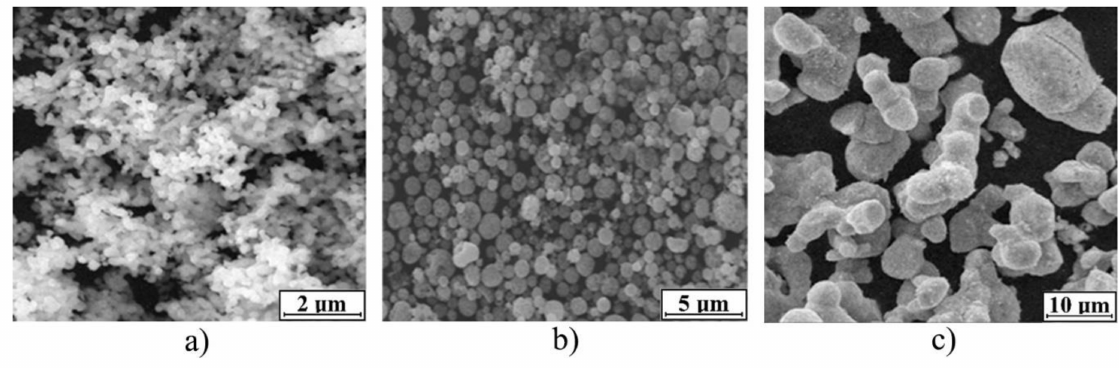
Figure 4. SEM images of iron samples: Fe(n–FeOOH) ( a ); Fe(n–Fe 2 O 3 _02) ( b ); Fe(n-FeO_02) ( c ). m-Fe_01 and m-Fe_02 samples consisted of rounded particles with an average diam- eter of 45 µ m and 30 µ m, respectively (see Figure 5). The n–Fe_01 and n–Fe_02 samples consisted of ultrafine particles of up to 100 nm in size.